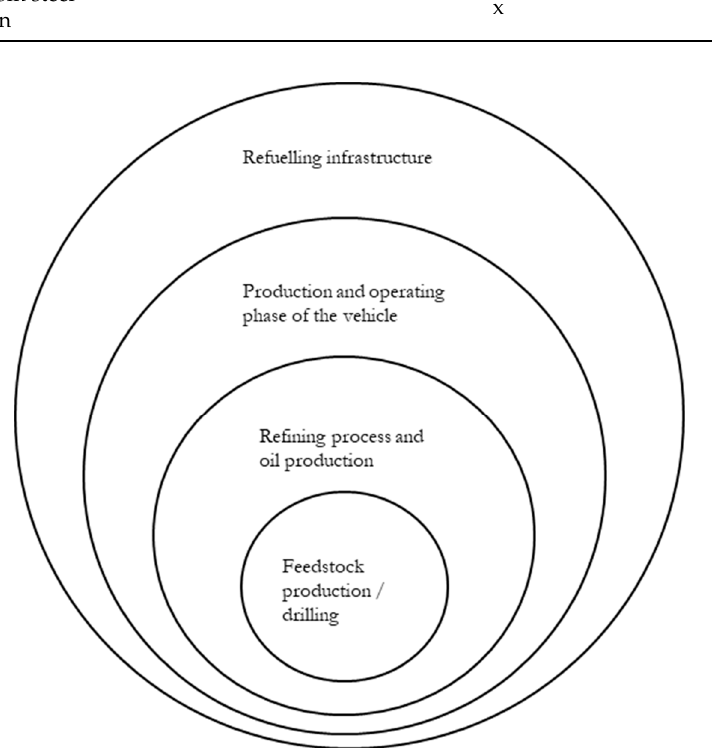
Figure 1. System boundaries used for grouping of criteria.